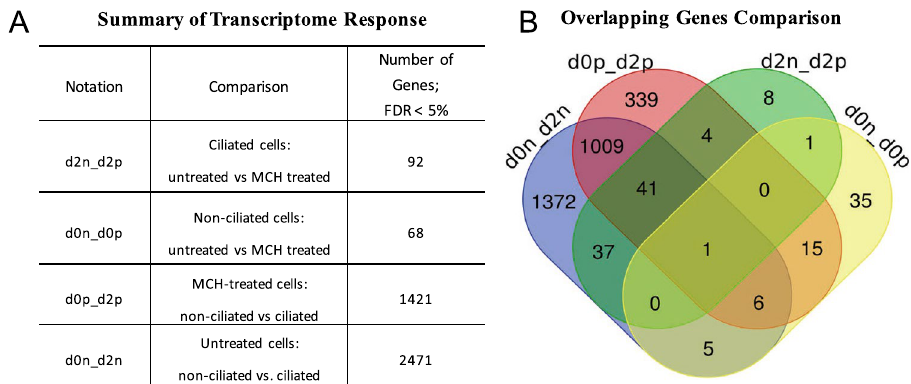
Figure 3. RNA-Seq was performed on total RNA samples isolated from either 3T3-L1 pre-adipocytes or Day 2 differentiating pre-adipocytes harboring primary cilia. Some samples were pretreated with 100 nM MCH prior to harvesting. ( A ) The number of responding genes reaching statistical significance with a False discovery rate (FDR) of < 0.05 is shown. ( B ) A Venn Diagram illustrating overlapping genes for all comparison groups.